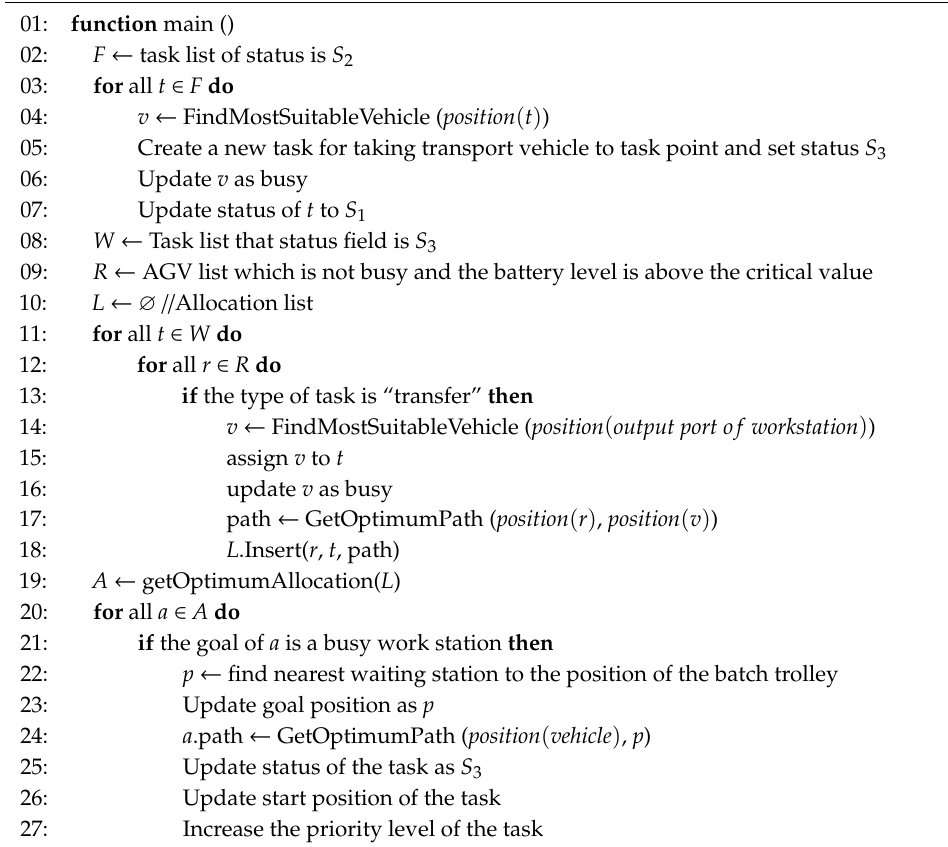
Algorithm 3 The Collaboration of Multi-AGVs and